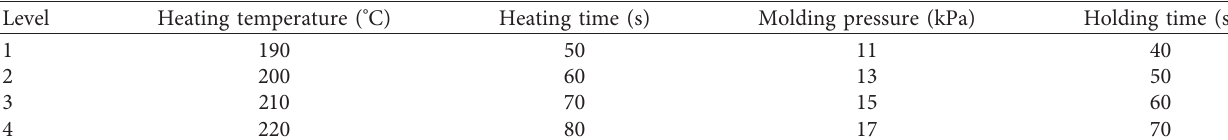
Table 1: Level factors of orthogonal experiments.